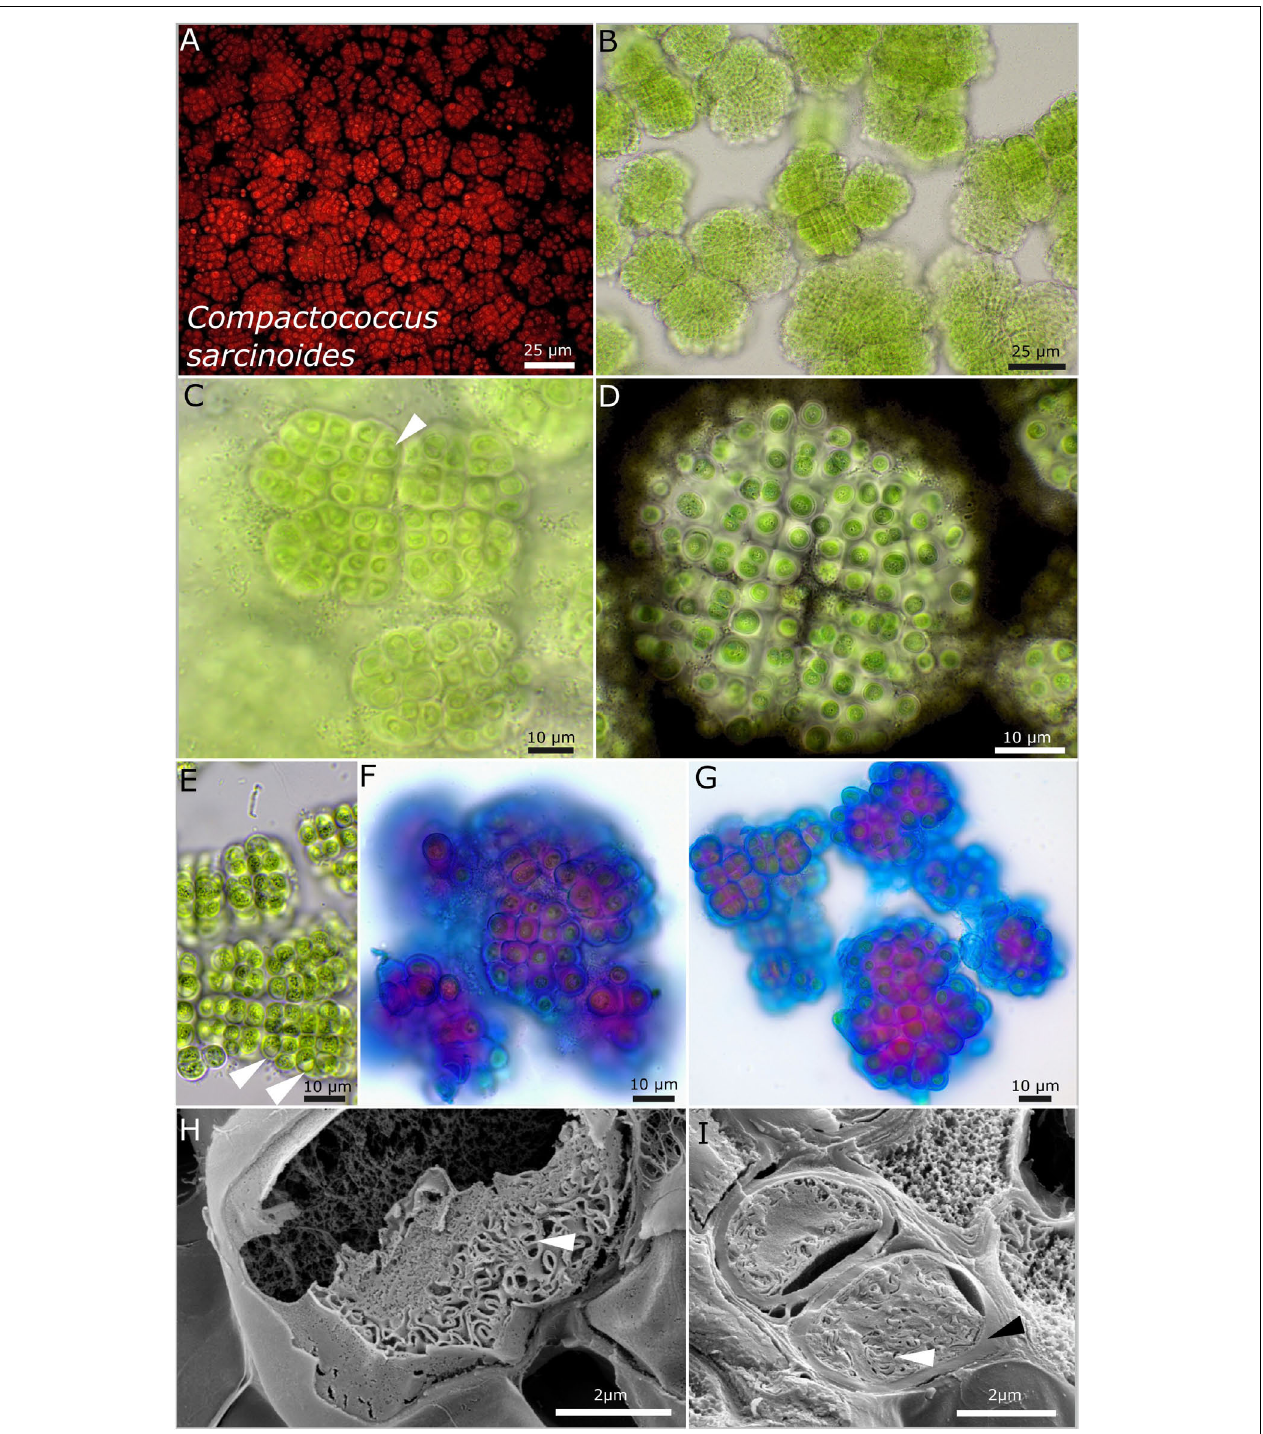
FIGURE 6 | Micrographs of Compactococcus sarcinoides . (A) Autofluorescence, (B–G) light microscopy, and (H,I) low-temperature scanning electron microscopy (SEM). (B) Overview of colonies arranged in equal packages made of rows of cells. (C) Close-up of small colonies with older cells that initially form vacuole-like structures (white arrow). (D) Indian ink highlighting the limited and lamellate character of the sheaths surrounding each single cell. Note the equal arrangement of the cells in rows and the division cross-dividing the colony in four quadrants. (E) Older colonies with vacuole-like structures bloating the cells (white arrow) and fine, crystalline granules in the center of the cells. (F,G) ACN staining coloring acid polysaccharides in blue that form the periphery of each sheath and inner sheath structure stained in purple due to a changing composition of the polysaccharides. (H,I) SEM images showing cut cells with thick capsule-like cell walls (black arrow) and the thylakoid membranes (white